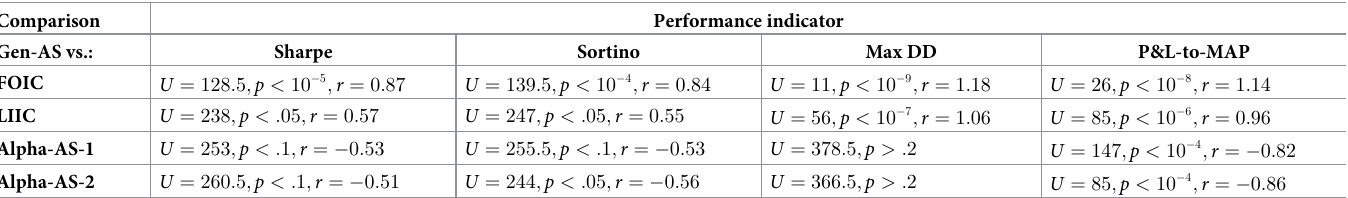
Table 7. Mann-Whitney tests comparing the four daily performance indicator values (Sharpe, Sortino, Max DD and P&L-to-MAP) obtained for the Gen-AS model with the corresponding values obtained for the other models, over the 30 test days. (Reported: Mann-Whitney U, significance level (p, with Bonferroni correction) and ffiffiffiffiffi p effect size ( r ¼ Z = 30